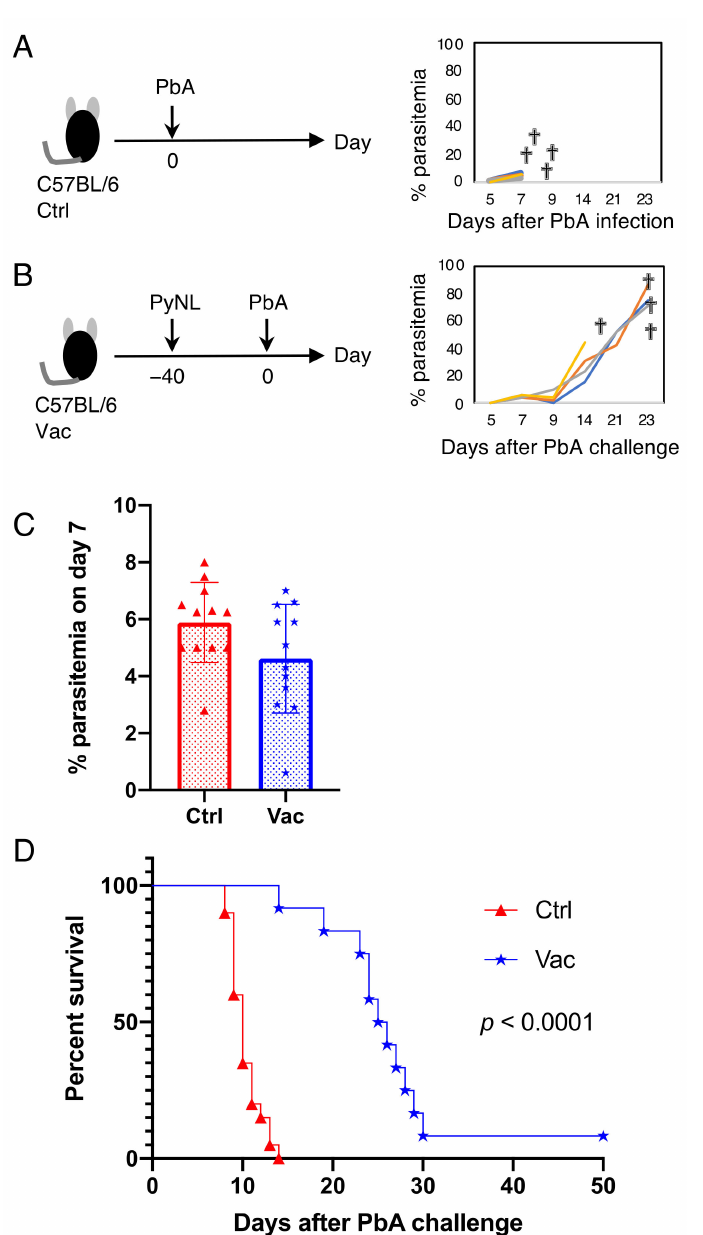
Figure 2. Live vaccination with Plasmodium yoelii 17XNL (PyNL) prolonged survival following challenge infection with P. berghei ANKA strain (PbA). ( A ) C57BL/6 mice were infected with PbA pRBC (control: Ctrl; left panel) and parasitemia was monitored (right panel). Each line shows parasitemia of one mouse (N = 4). “†” indicates death. A representative dataset is shown from more than 10 independent experiments (N = 4). ( B ) Mice vaccinated with PyNL (Vac) were challenged with PbA (left panel) and parasitemia was monitored (right panel; N = 4). A representative dataset is shown from 3 independent experiments. ( C ) The percentage of parasitemia on day 7 in Ctrl (Red; N = 12) and Vac mice infected with PbA (Blue; N = 12). Each symbol represents one mouse. Data represent the mean ± standard deviation (SD). ( D ) Survival curve of Ctrl (Red; N = 20) and Vac mice infected with PbA (Blue; N = 12). Data were pooled from 3 independent experiments. p values were determined by Gehan–Breslow–Wilcoxon test. One mouse out of 12 cleared PbA infection, with peak parasitemia at 0.6% on day